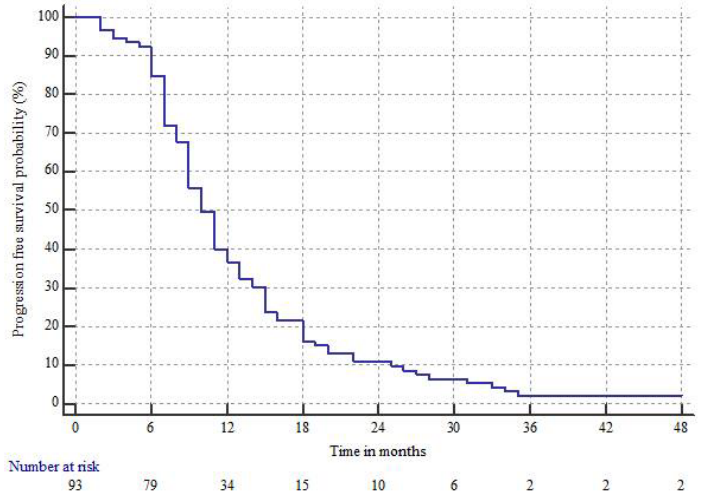
Figure 2. Progression free survival (PFS).